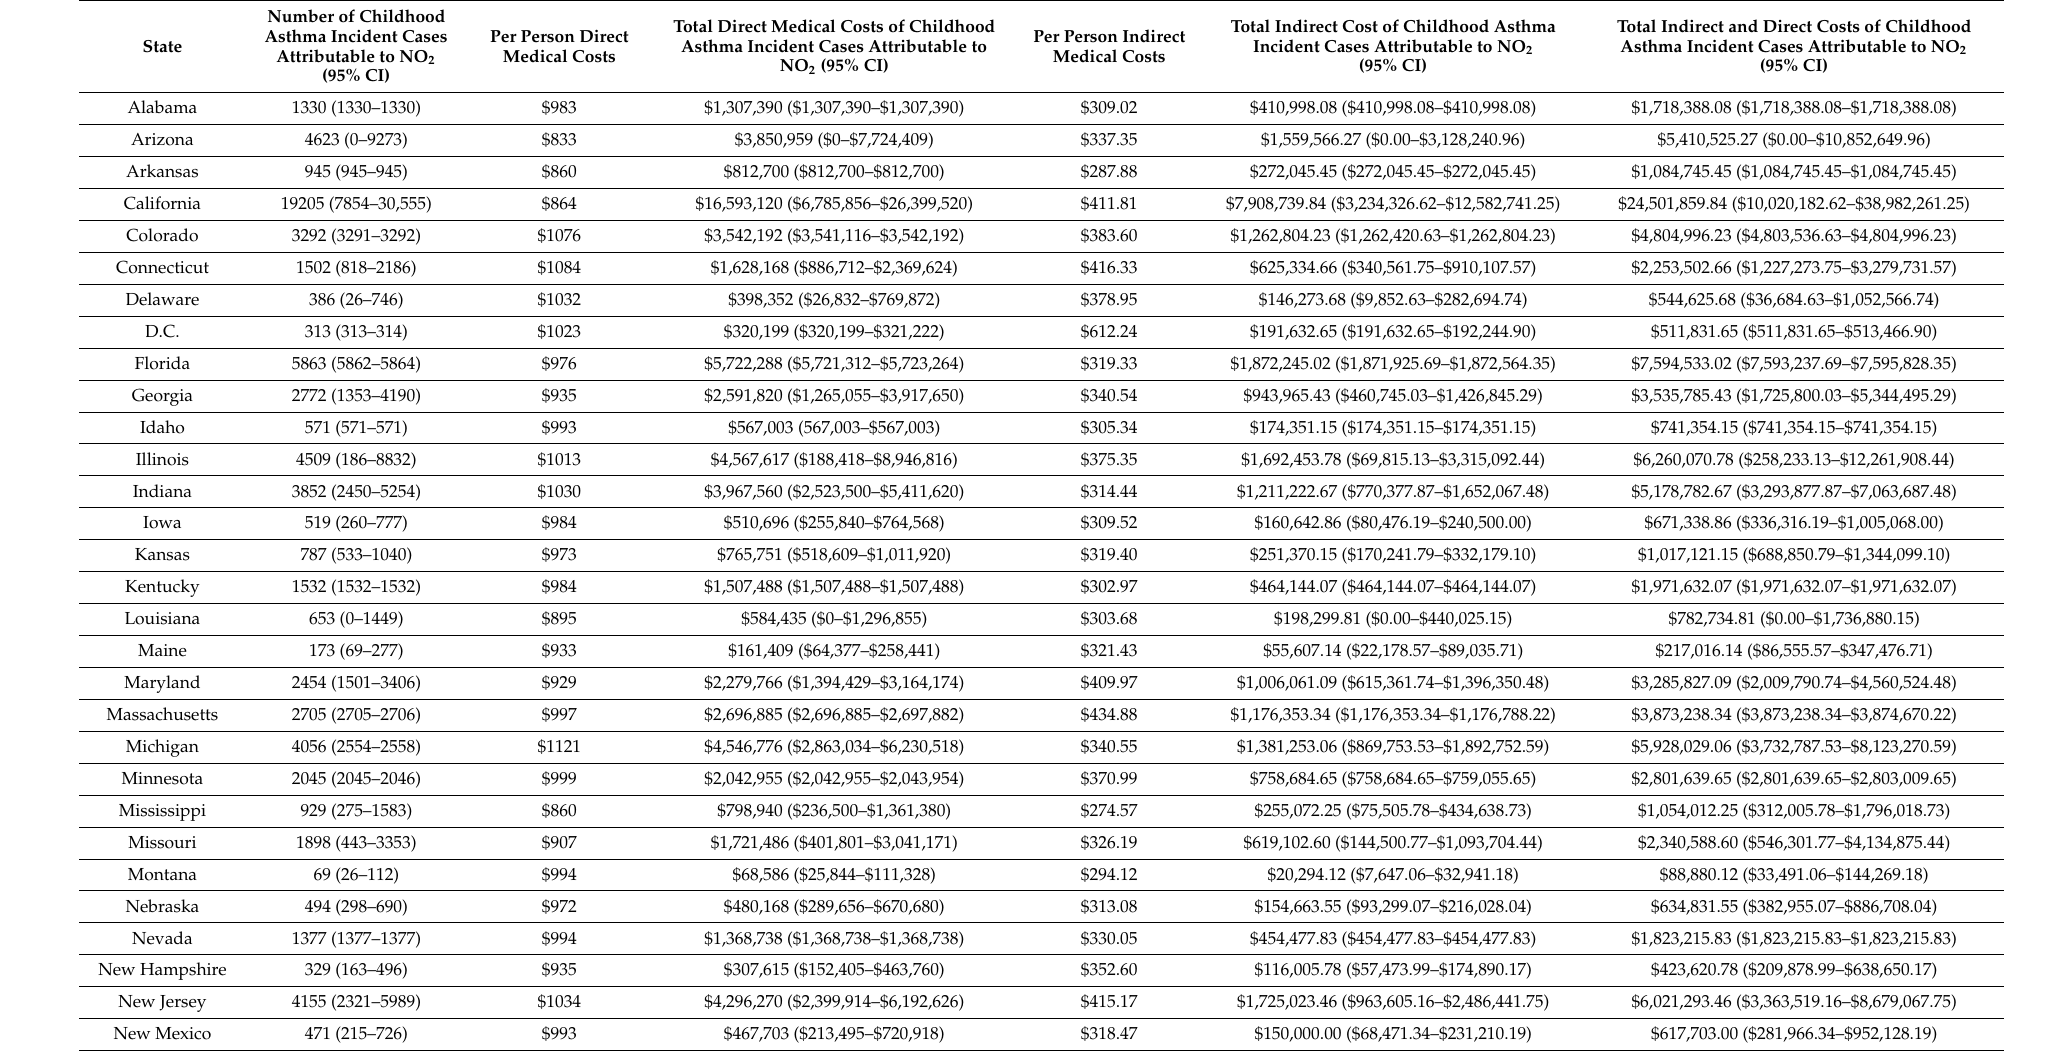
Table 4. State annual economic